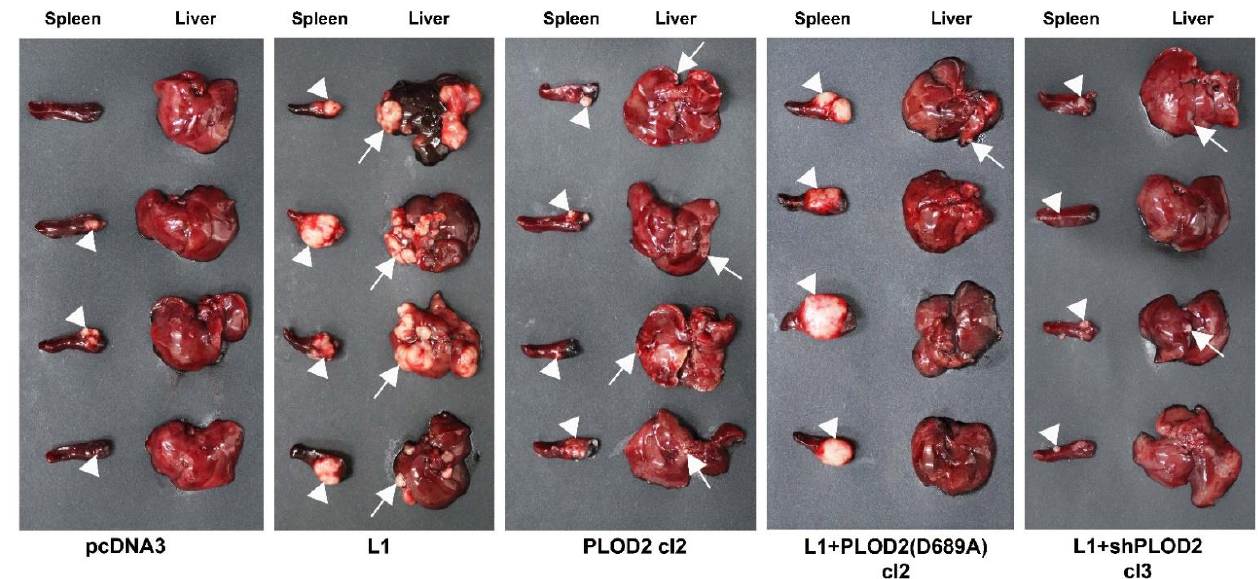
Figure 4. The liver metastasis of the CRC cells conferred by L1 transfection requires endogenous PLOD2 expression. The CRC cell clones described in Figure 2A were injected into the tip of the spleen in groups of four nude mice, and the development of tumors at the site of injection and liver metastasis were determined five weeks after the injection of the various CRC cell clones. White triangles mark tumor growth in the spleen. White arrows mark metastatic foci in the liver.